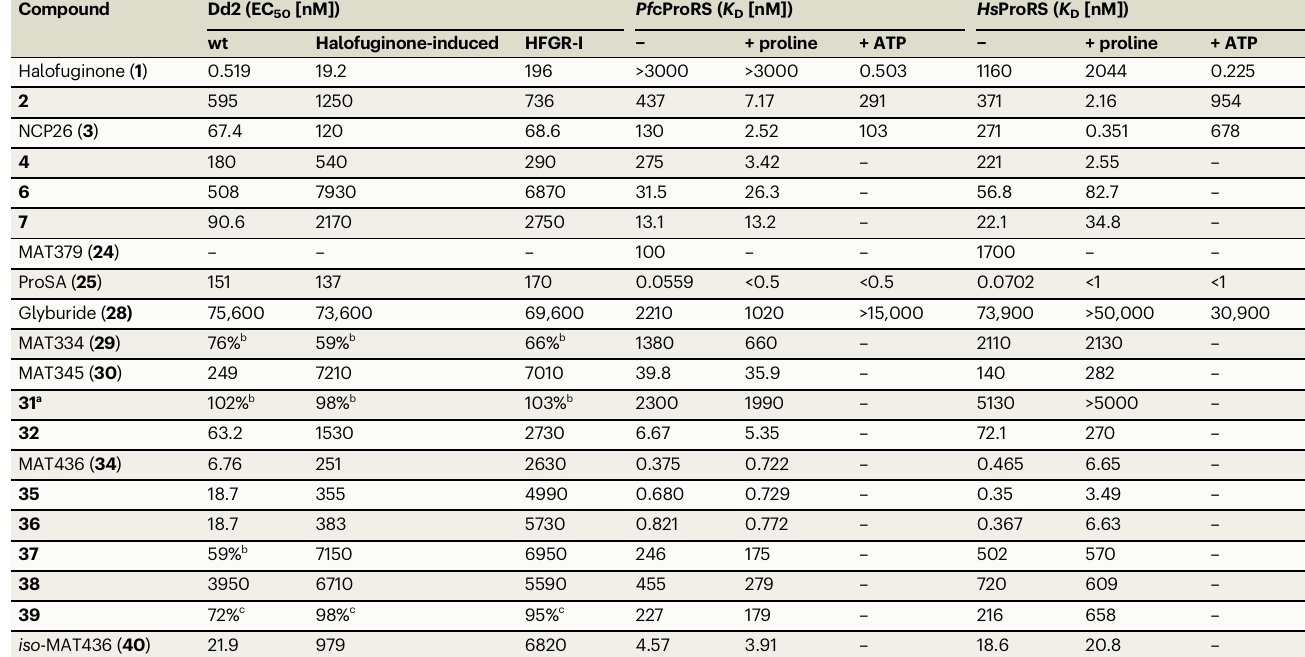
TR-FRETdataarepresentedasthemeanof n ≥ 2independentreplicatewellsandarerepresentativeof n ≥ 3independentexperiments.Parasite(Dd2)growthdataarepresentedasthemeanof n ≥ 2 biological replicates and arerepresentative of n ≥ 3